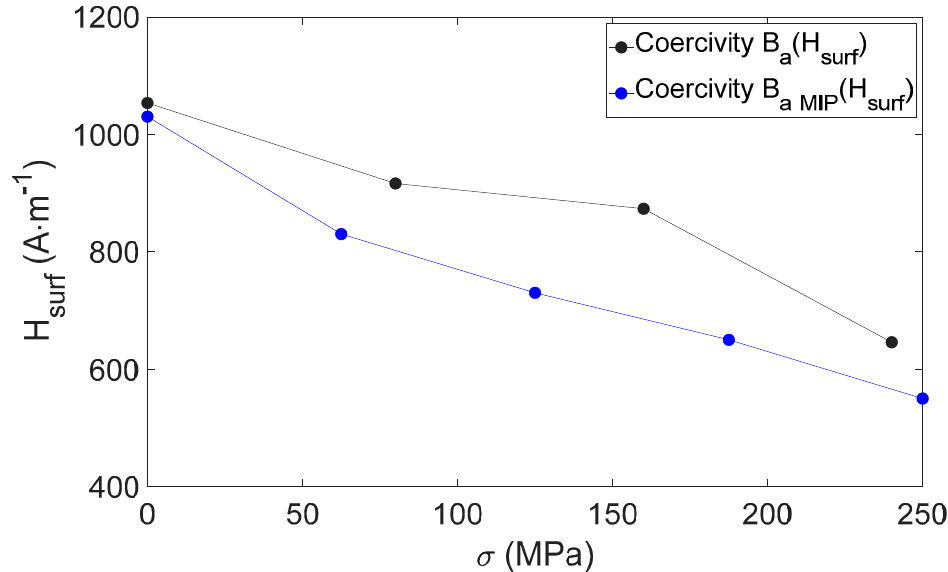
Figure 14. Coercivity vs. stress for B a (H surf ) and B a MIP (H surf ) hysteresis cycles.